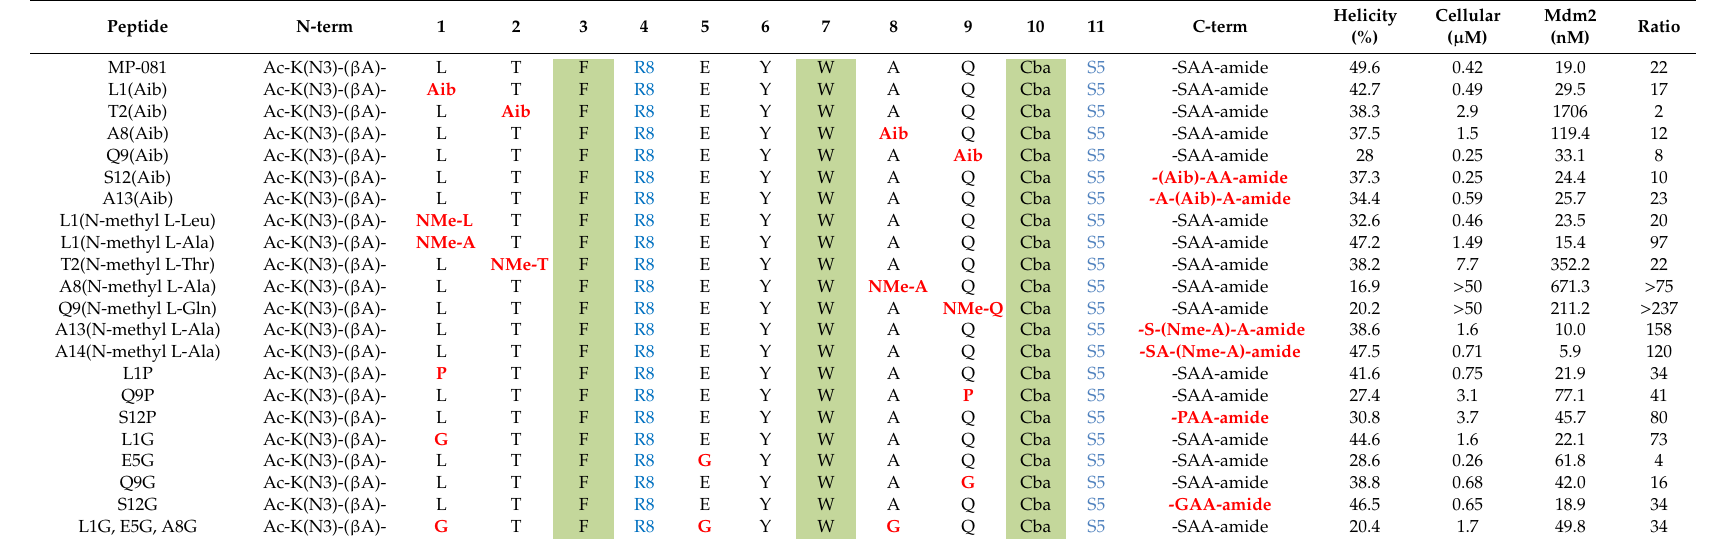
Table 2. Sequence, helicity, cellular activity (EC50), and Mdm2 binding (Kd) of MP-081 and derivatives. A variety of putative helix inducers and helix-breakers are accommodated in the context of stapled peptide MP-081 with most variants maintaining helical structure, Mdm2 binding and cellular activity. Ratio refers to the fold-shift between the binding a ffi nity and cellular